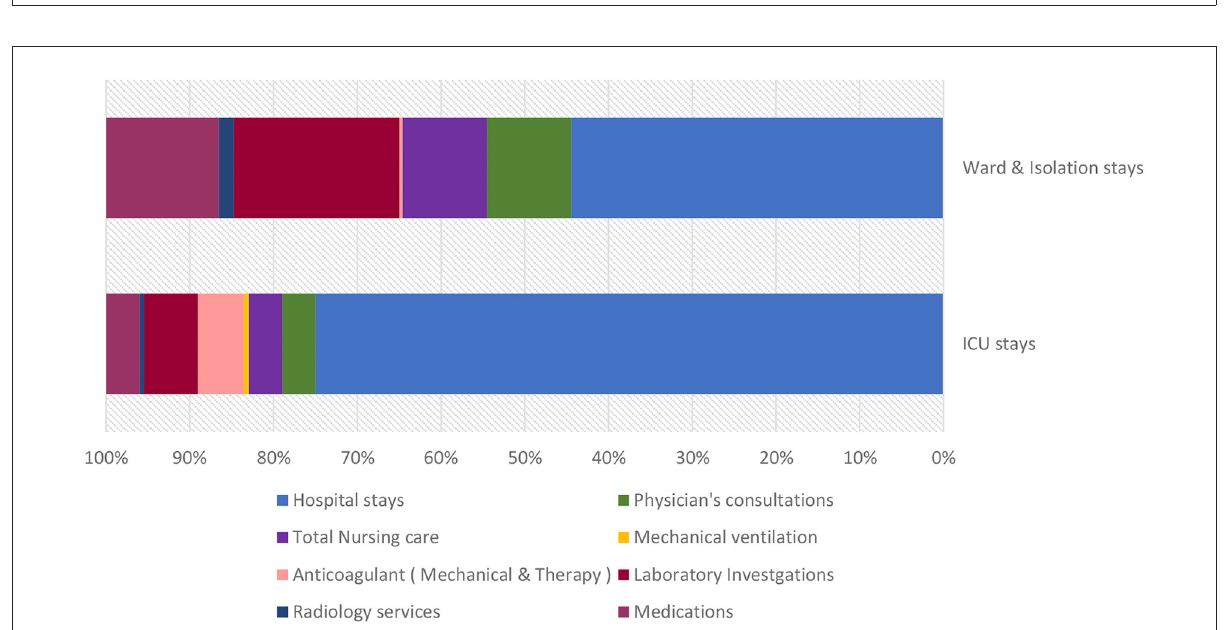
FIGURE3 Distribution of total hospital costs for hospitalized patients diagnosed with COVID-19.